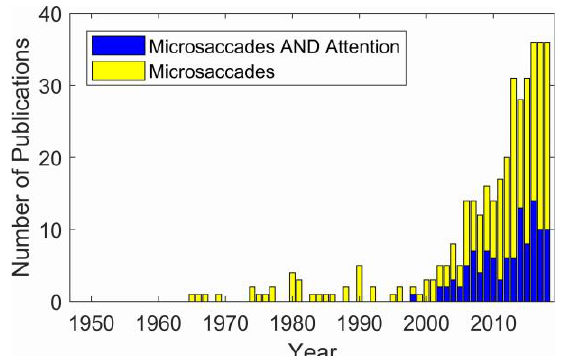
Figure 1: Numbers of papers that contain either the search term ‘microsaccades’ (yellow) or ‘microsaccades AND at- tention’ (blue) in abstract, title or keyword searches in Sco- pus, from 1948 to 2018. It should be noted that papers prior to 1996 may not be searchable via Scopus. Indeed a sub- stantial number of papers prior to that date are included in our review, but not in the database search. However, the general trend since 1996 is